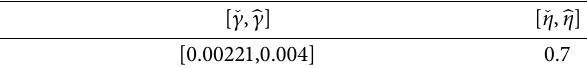
(Figure 7(b)), stripe pattern (Figure 7(c)), mixture of cold spot and stripe pattern (Figure 7(d)), cold spot pattern (Figure 7(e)) with the increasing of the interval variable of q .